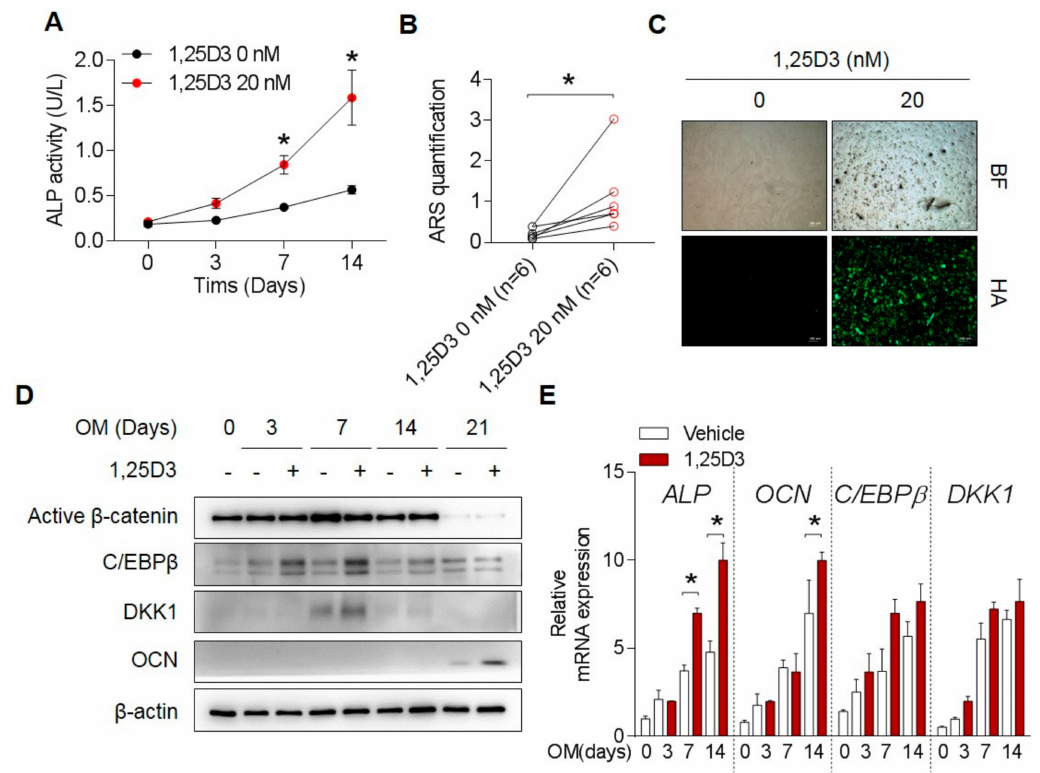
Figure 1. 1,25D3 transiently increases expression of DKK1 and C / EBP β during osteoblast di ff erentiation. Osteoprogenitors were treated with 0 or 20 nM 1,25D3 under osteoblast di ff erentiation. ( A ) Intercellular ALP activity at indicated days, ( B ) ARS quantification at 14 days, ( C ) Hydroxyapatite staining at 14 days. BF, Bright Field; HA, Hydroxyapatite. Representative data are shown. * p < 0.05; (mean ± SD; n = 6) ( D ) Protein levels were determined by immunoblotting at indicated days. ( E ) mRNA levels were determined by qPCR at indicated days. Representative data are shown. * p < 0.05; (mean ± SD; n =